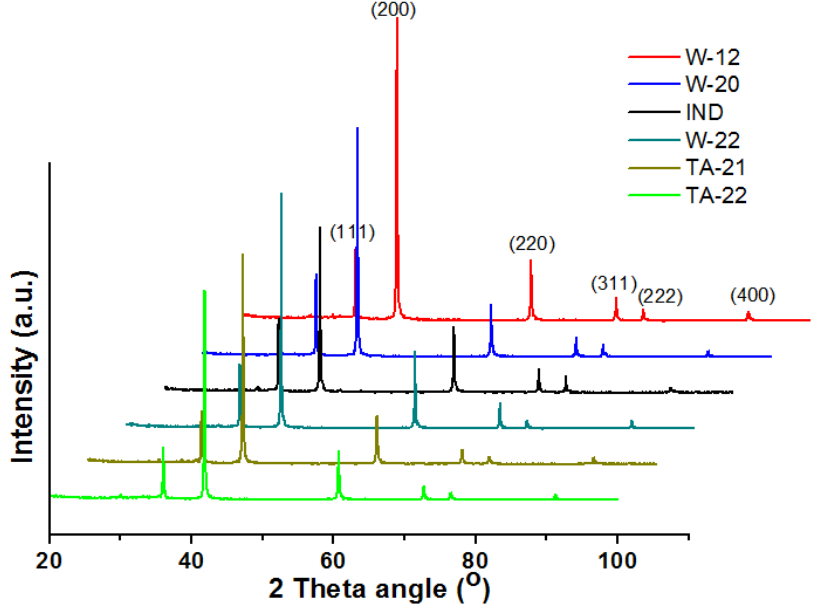
Figure 1. XRPD patterns of catalyst precursors.